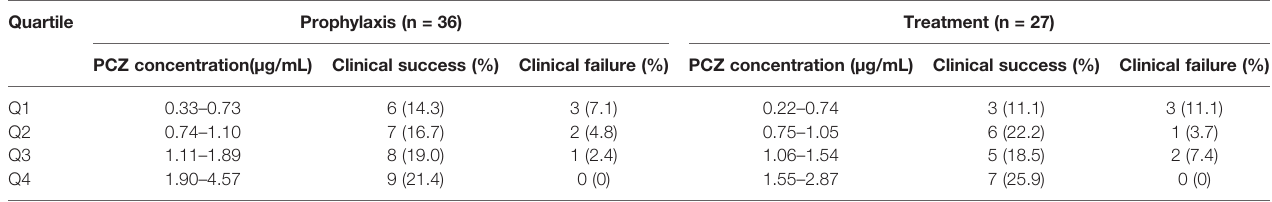
TABLE 2 | Association between the PCZ steady-state average plasma concentrations quartiles (Q) and clinical response in the whole population. Quartile Prophylaxis (n = 36)